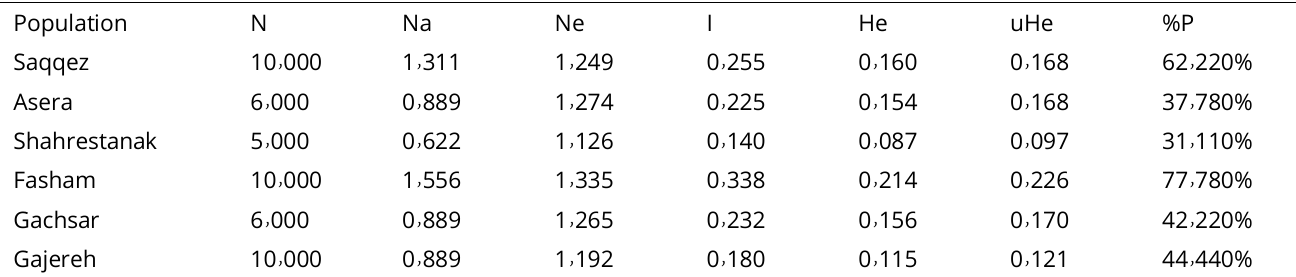
Table 5. Genetic diversity parameters determined in the studied populations.